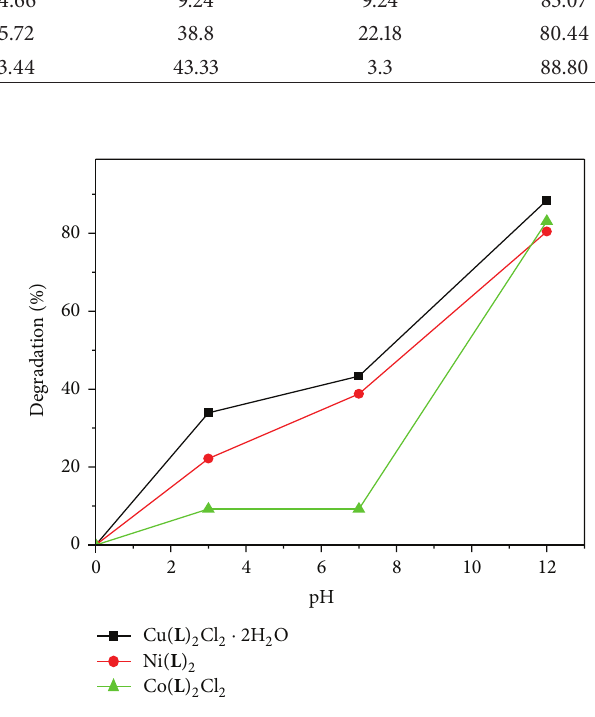
Figure 4: % degradation of methylene blue at different pH condi-